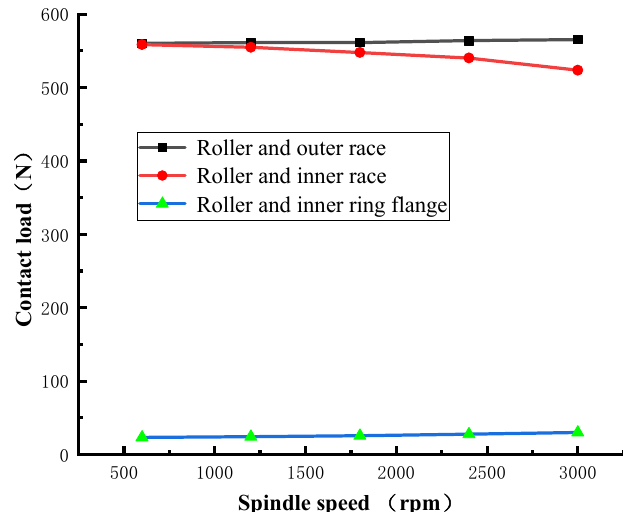
Figure 14. Influence of speed.